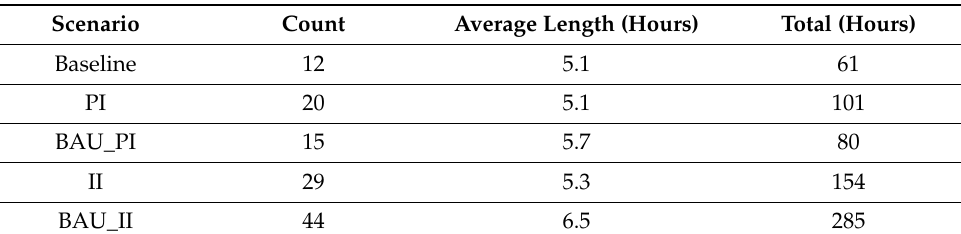
Table 9. Instances of negative electricity prices, showing that, in all cases, negative hours increase, with geographic diversity increasing instances but supply diversity reducing them by almost half.